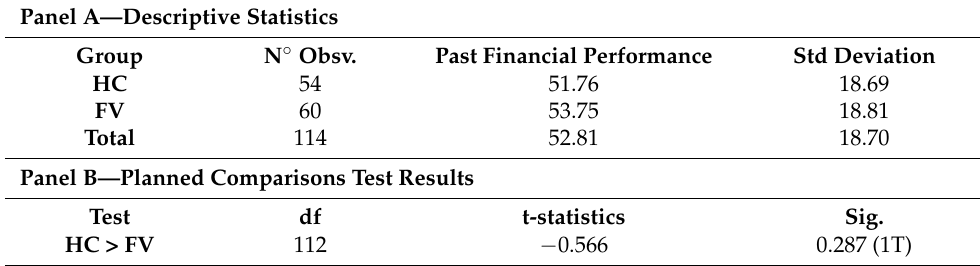
Table 3. Analysis of Past